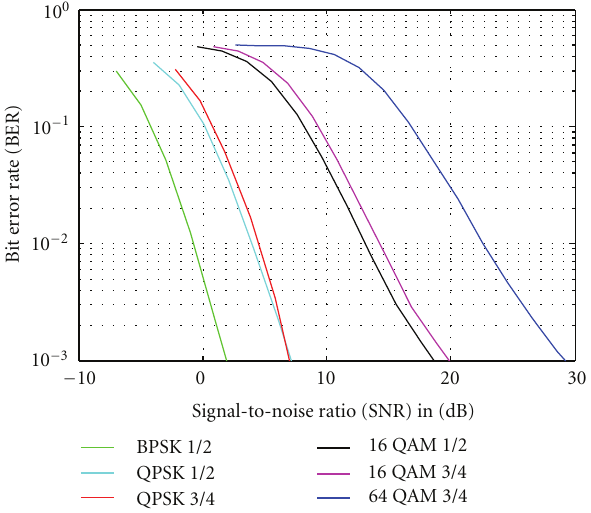
Figure 12: BER performance of DSA-SINR across di ff erent MCSs in uncorrelated channel.